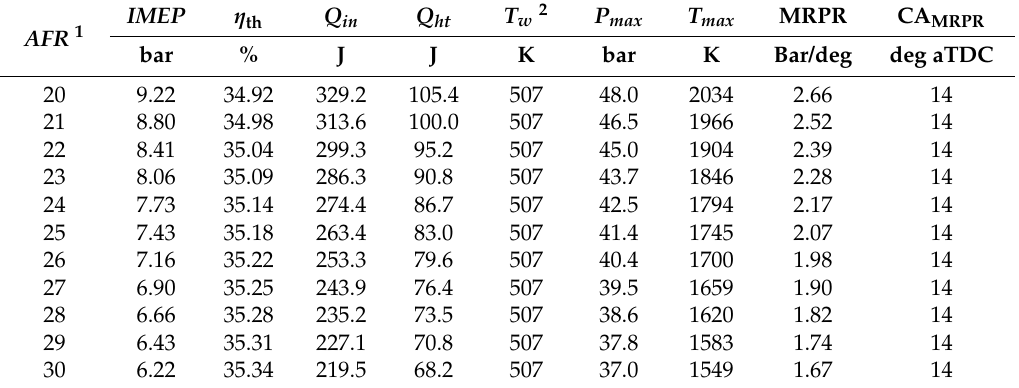
Table A6. Air cycle simulated results with various heat inputs for combustion pattern 3. AFR